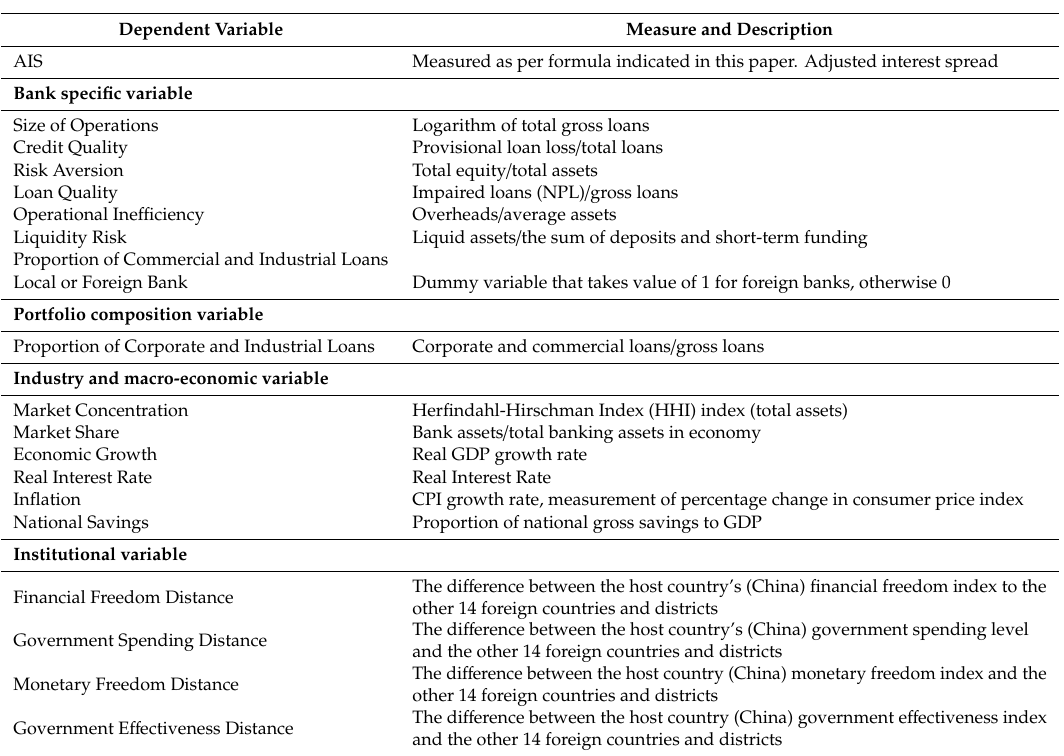
Table 1. Description of